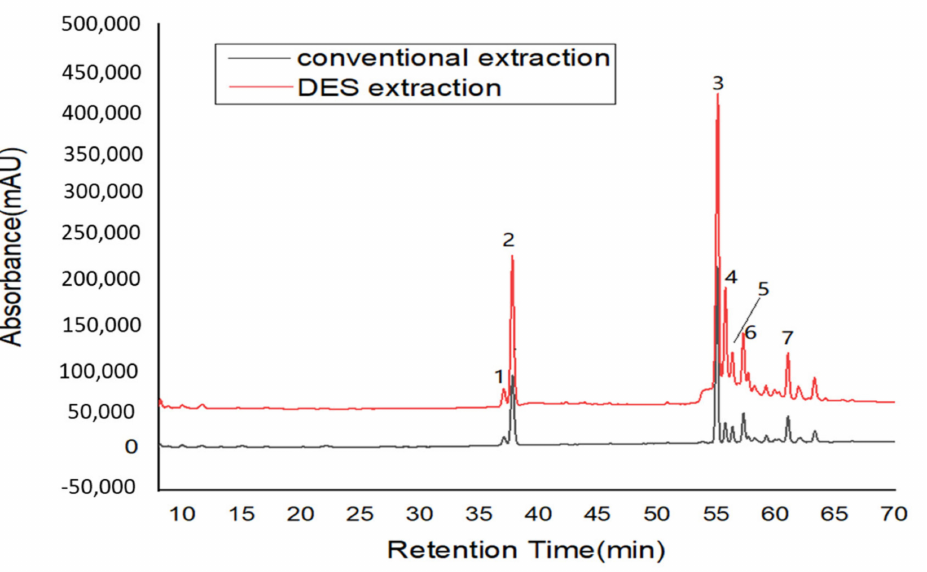
Figure 4. The HPLC chromatogram ginsenosides with different extraction methods (1: Rg1; 2: Re; 3: Rb1; 4: Rc; 5: Rb2; 6: Rb3; 7: Rd).